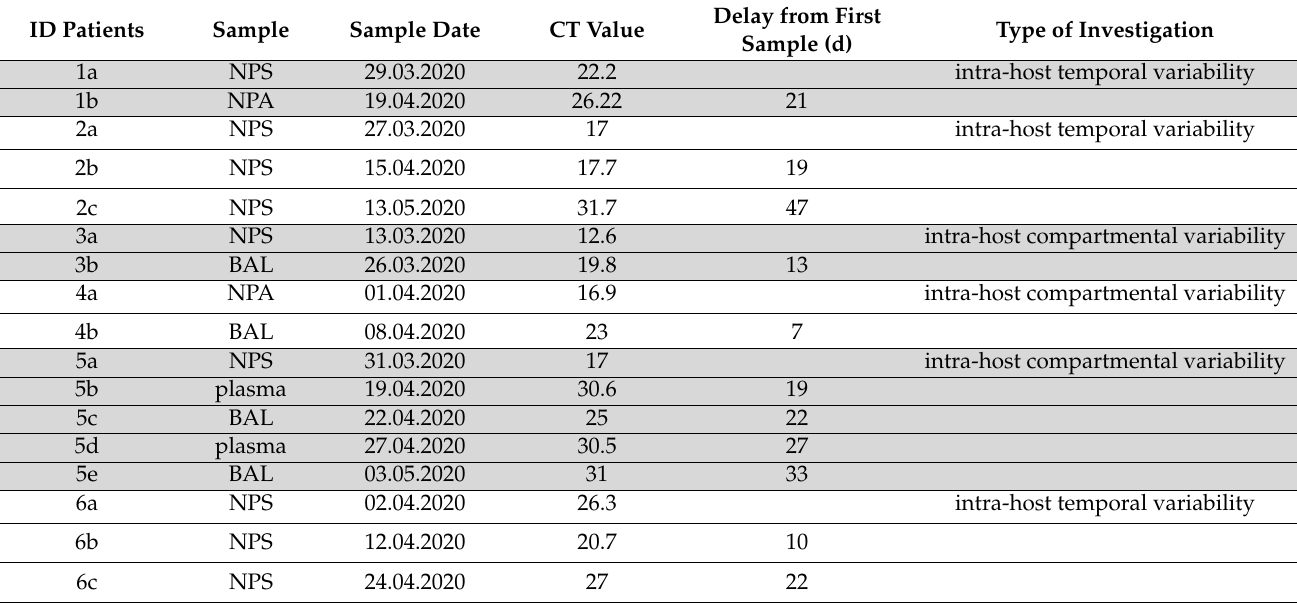
Table 2. Characteristics of samples analyzed by